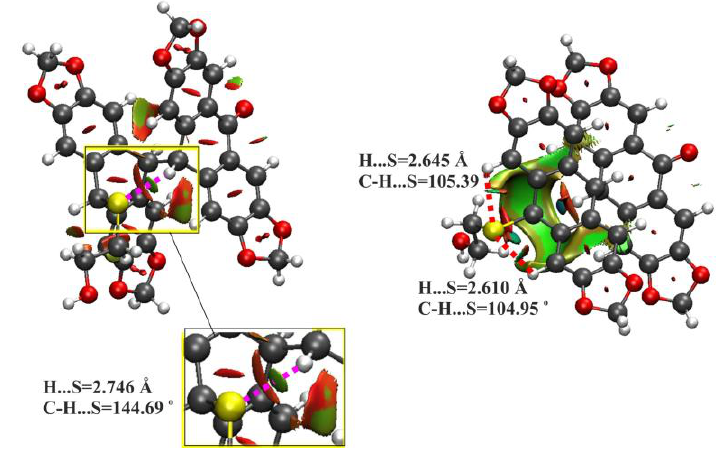
Figure 3. Color-filled reduced-density gradient (RDG) isosurfaces depicting non-covalent interactions in cis -9b (left) and trans -9b (right). The pink and red dashed lines denote weak C-H···S hydrogen bonds, respectively.